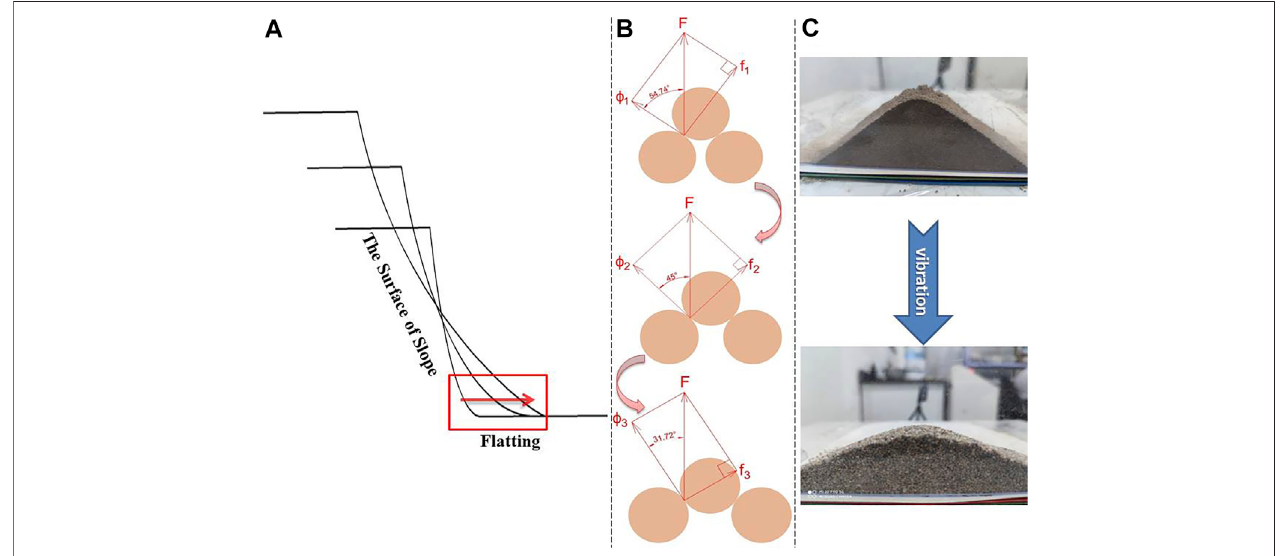
FIGURE 11 | (A) Slope changes caused by vibration. (B) Vibration induced contact model changes in slopes. (C) The change of accumulation body caused by vibration.